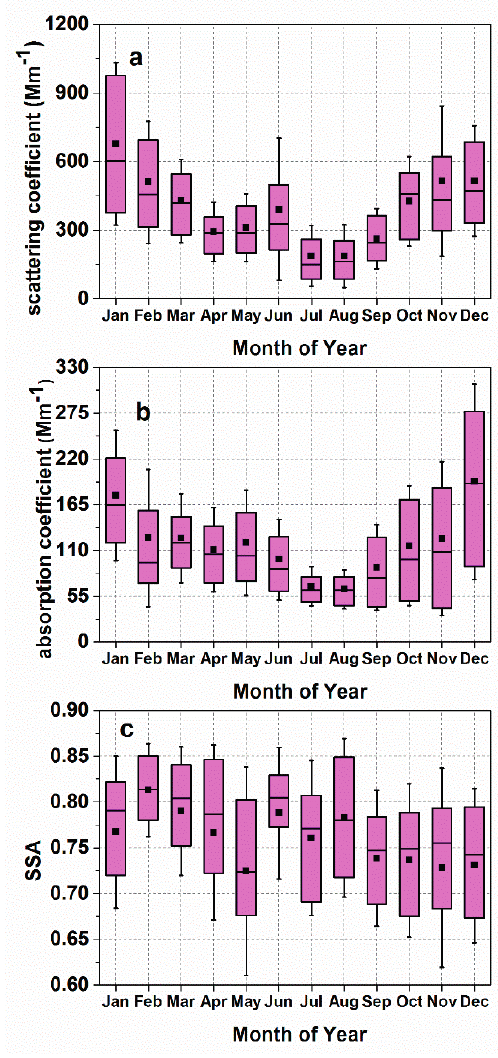
Figure 4. Box plots of annual variation of aerosol optical parameters including mean value (solid black square), median (horizontal line within the box), 25th and 75th percentiles (upper and lower edges of box), and standard deviation (shorter horizontal lines) for different months: ( a ) aerosol scattering coefficients ( σ ( c ) single scattering albedo